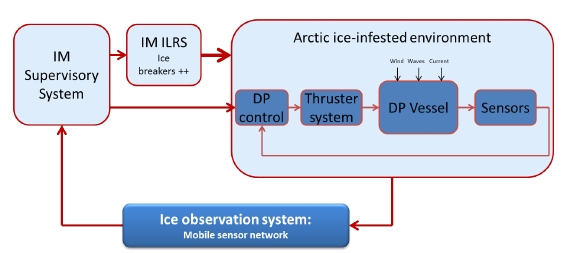
Figure 1: KMB Arctic DP system topology proposal. Figure 2: Image processing system in support to Arctic